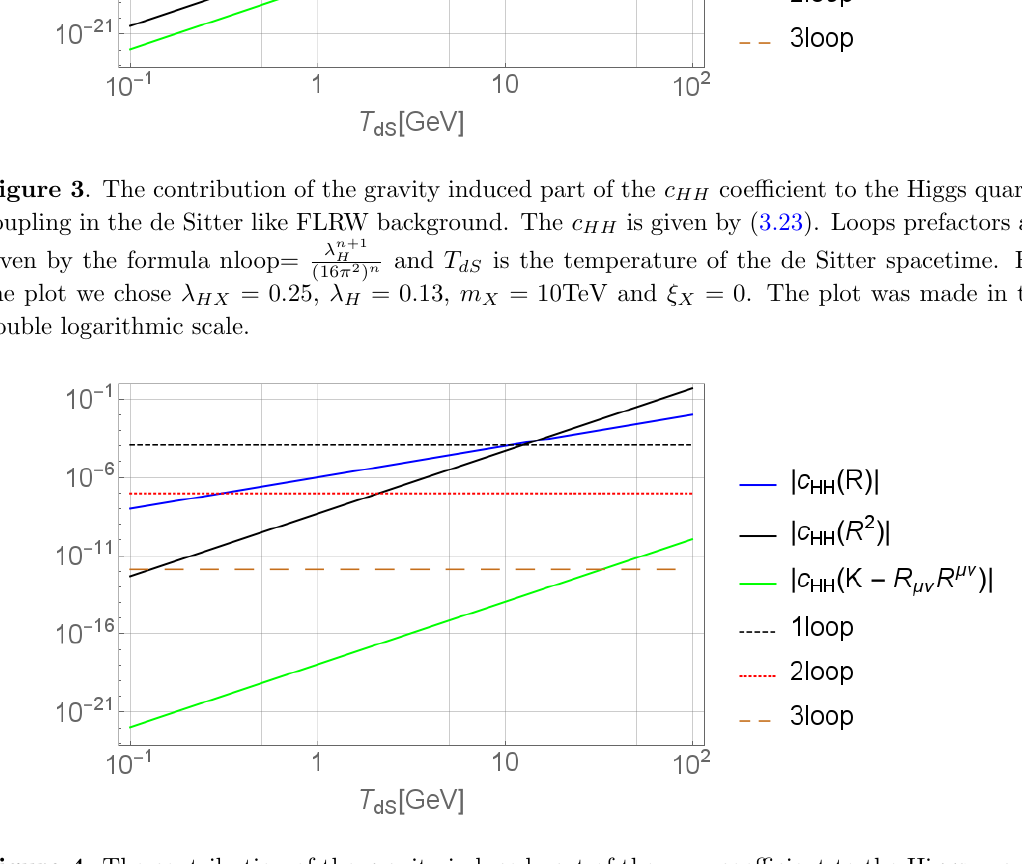
Figure 4 . The contribution of the gravity induced part of the c HH coe(cid:14)cient to the Higgs quartic coupling in the de Sitter like FLRW background. The c HH is given by (3.23). Loops prefactors are n +1 given by the formula nloop= (cid:21) and T dS is the temperature of the de Sitter spacetime. For H (16 (cid:25) 2 ) n the plot we chose (cid:21) HX = 0 : 25, (cid:21) H = 0 : 13, m X = 10TeV and (cid:24) X = 10 3 . The plot was made in the double logarithmic